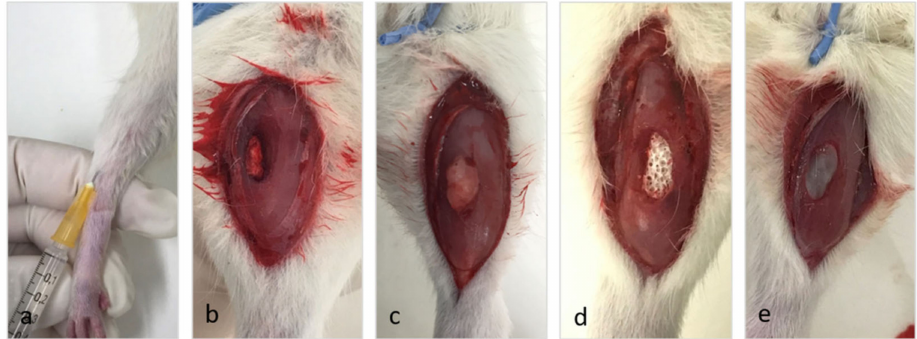
Figure 8. Control and experimental groups. ( a ) Intramuscular injection of mepivacaine (RC group). Implantation in the muscle defect of: ( b ) A resorbable hemostatic sponge (FC group), ( c ) autolo- gous adipose tissue (AT group), ( d ) Osteovit ® (OS group), or ( e ) a decellularized muscle matrix (DM